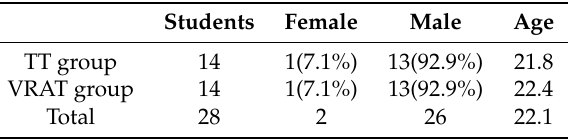
Table 1. Participant